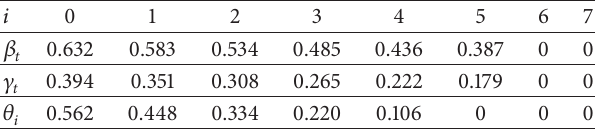
Table 2: Threshold values 𝛽 , 𝛾 , and 𝜃 of each